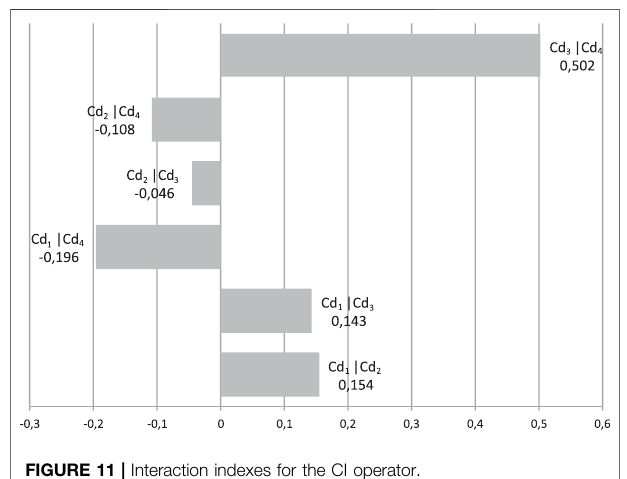
FIGURE 11 | Interaction indexes for the CI operator.